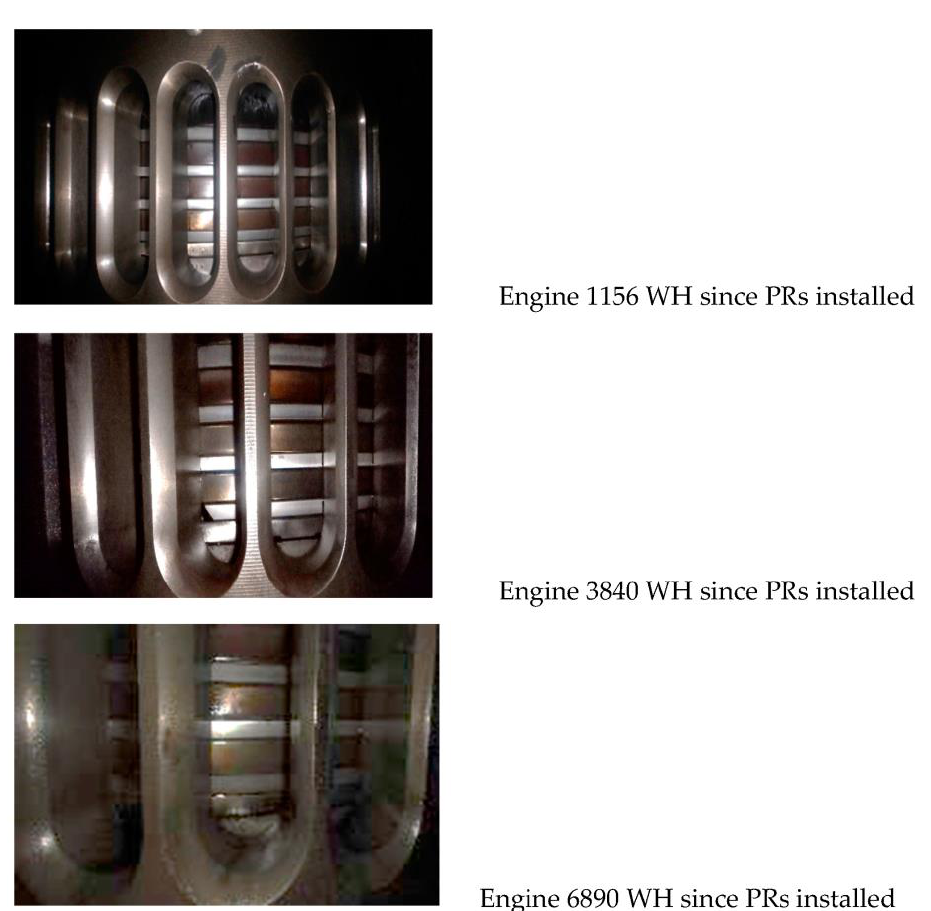
Figure 2. Example of piston rings’ condition depending on the engine’s WH since new PRs had been installed.